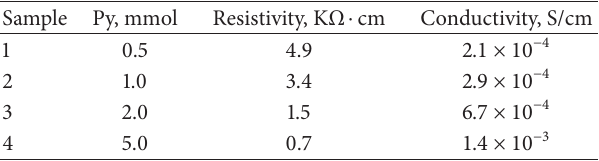
Table 1: Electrical conductivities of the PPy/T-CNs films. Sample Py, mmol